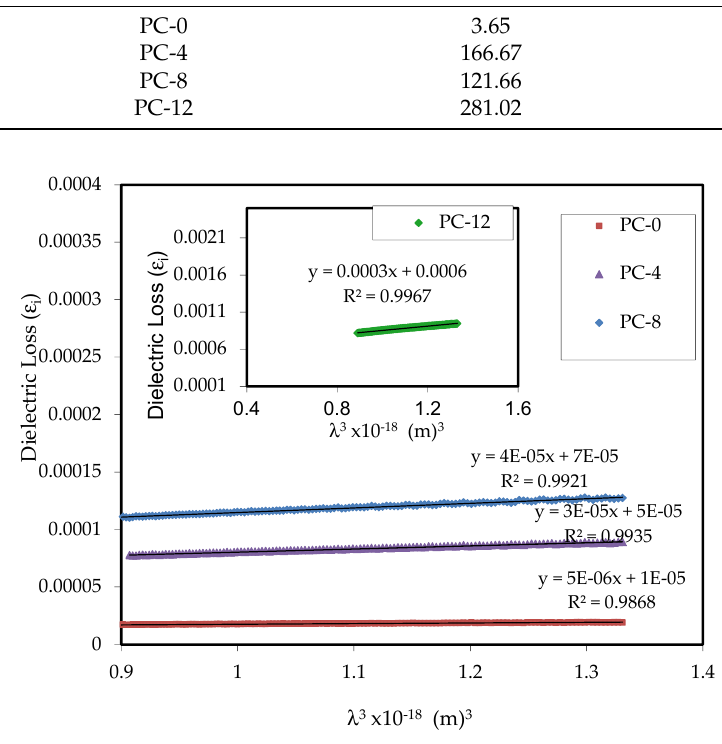
3 for the systems.